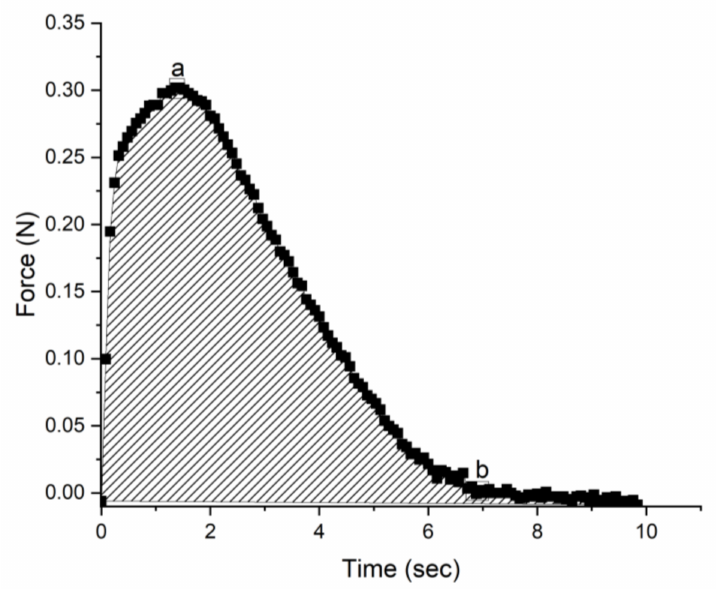
Figure 3. Sample Force–Time plot obtained from the texture analyzer; a is the maximum force, and b represents the filament breakup time. The overall energy expenditure for break-up (work) is the shaded